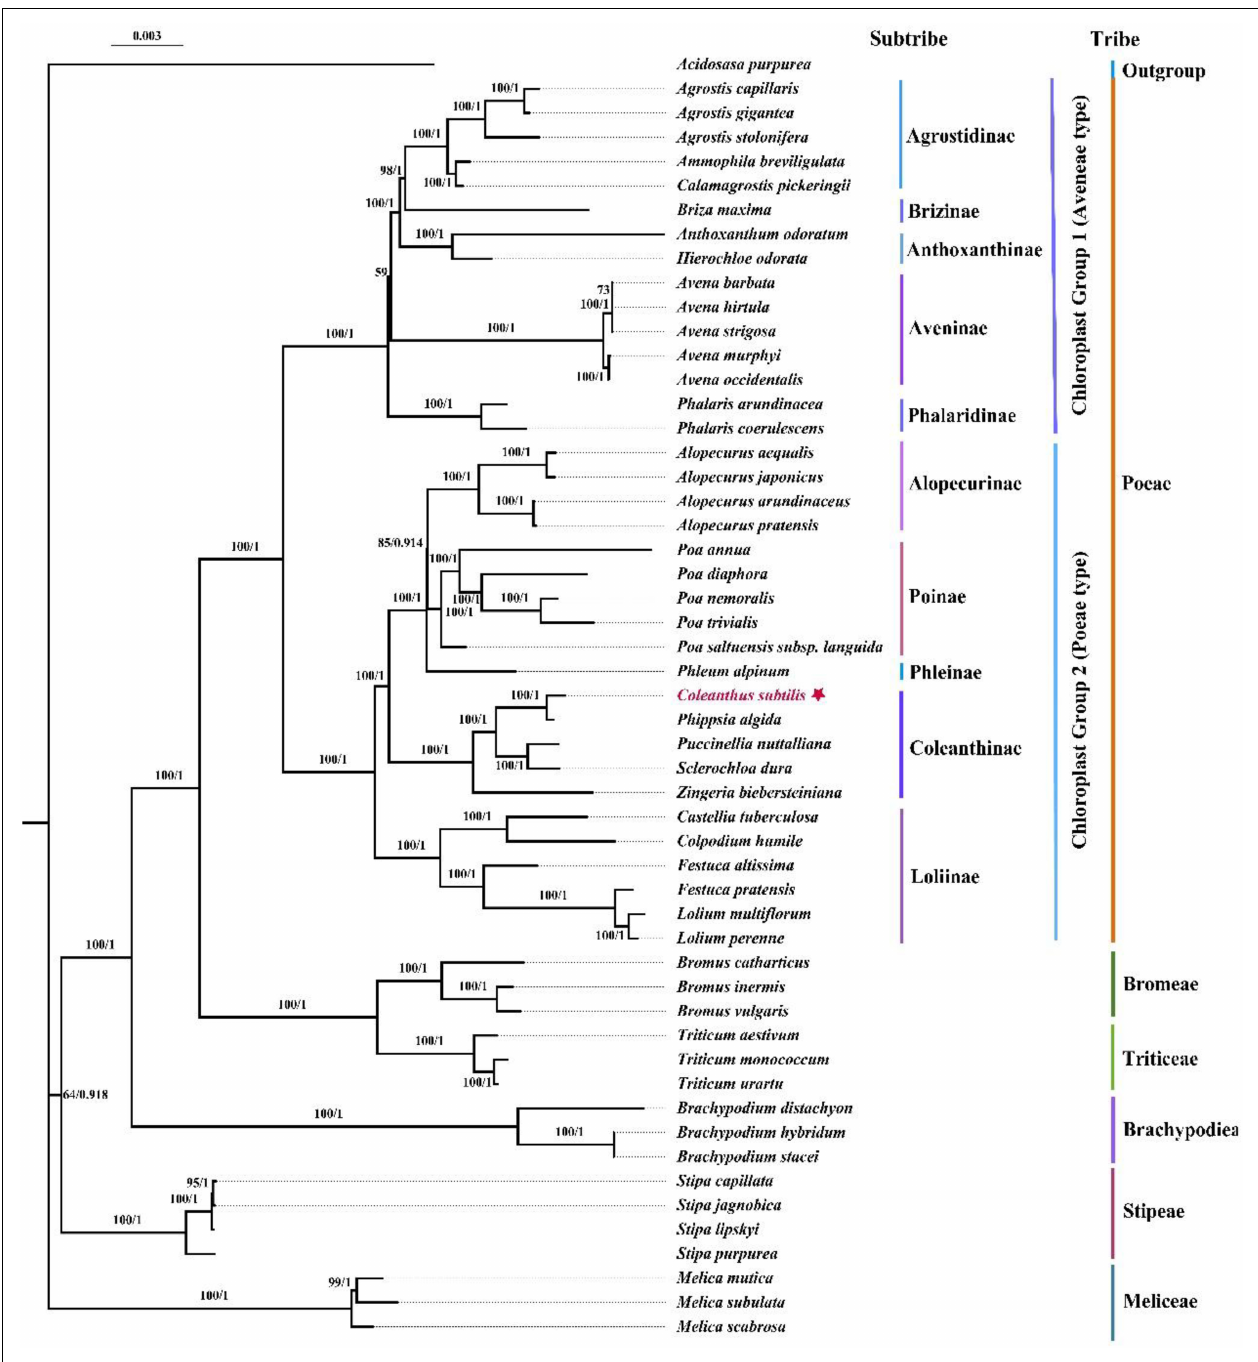
FIGURE 10 | Phylogenetic trees were generated based on the 76 shared protein-coding sequences of 53 species using maximum likelihood (ML) and Bayesian (BI) methods. The ML tree and BI tree have a consistent topology. The ML bootstrap values/Bayesian posterior probabilities are displayed on the nodes. To make Coleanthus subtilis more visible, it was marked with a